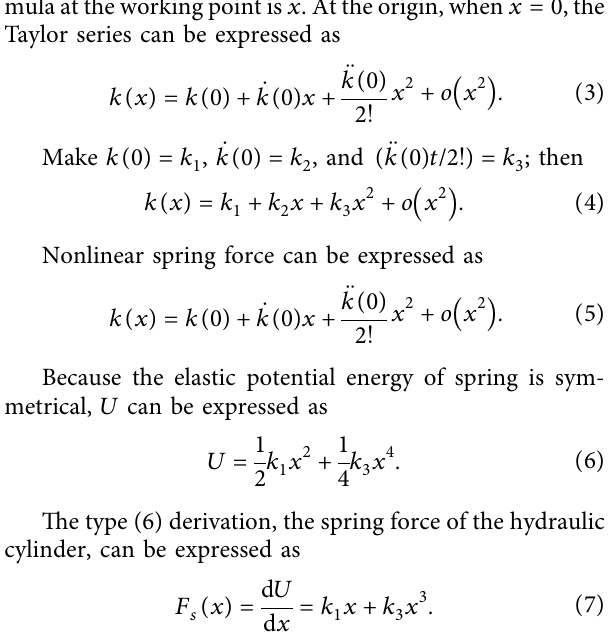
Figure 1: The four-roller mill physical map.